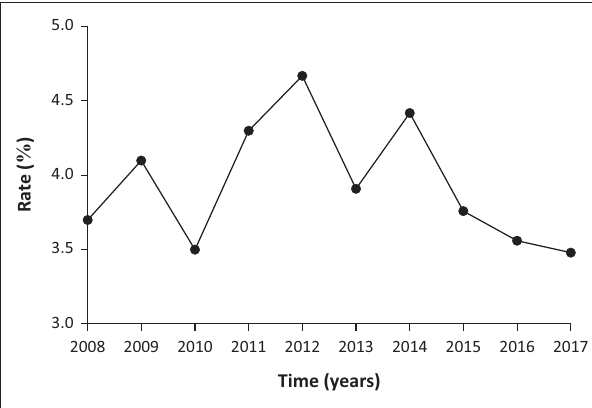
FIGURE 1: Trend of suicide prevalence in all medico-legal cases examined over the decade